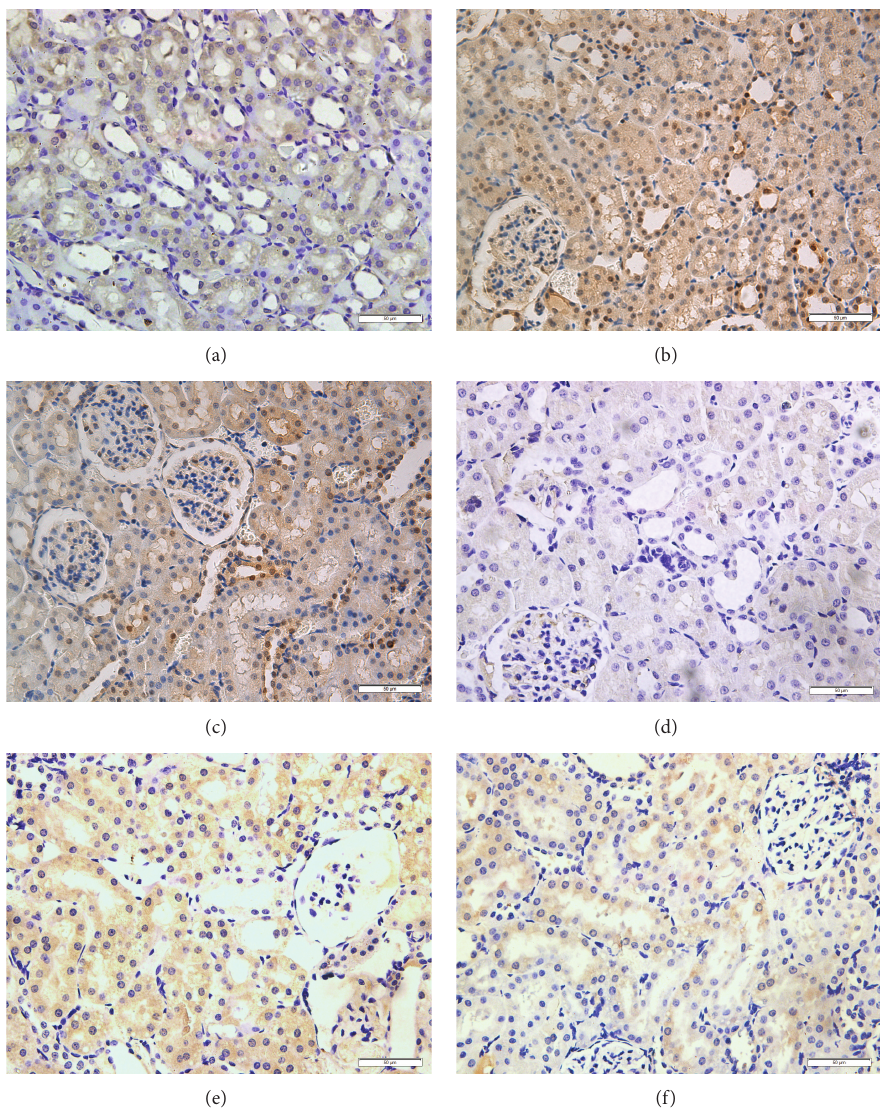
Figure 5: The expressions of NF- 𝜅 B p65 and 3-nitrotyrosine were detected in renal tissues at 12 hours in all groups (original magnification × 400). (a) In SO group, weak immunoreactivity of NF- 𝜅 B was mainly shown in cytoplasts. (b) In SAP group, intense immunoreactivity of NF- 𝜅 B was shown in nucleus. (c) In HRS group, lower immunoreactivity of NF- 𝜅 B was shown in nucleus than SAP group. (d) In SO group,